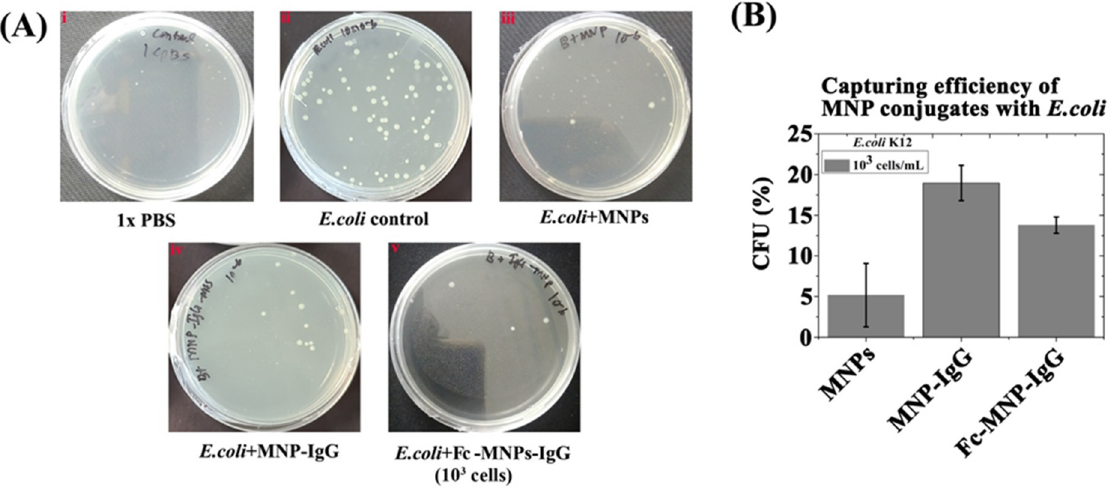
Figure 5. CFU assay for the assessment of binding efficiency of MNPs conjugates. ( A ) Photographic images of CFU assay for different MNPs conjugates (i) PBS, (ii) E. coli control (10 3 cells/mL), (iii) E. coli captured by MNPs from 10 3 cells/mL, (iv) E. coli captured by MNP-IgG, (v) E. coli (10 3 cells/mL) captured by Fc-MNP-IgG. ( B ) Bar graph indicates the capturing efficiency of different MNPs conju- gates with 10 3 cells/mL E. coli as the percentage of CFU in respect to control. Error bars represent the standard deviation of means for triplicate.